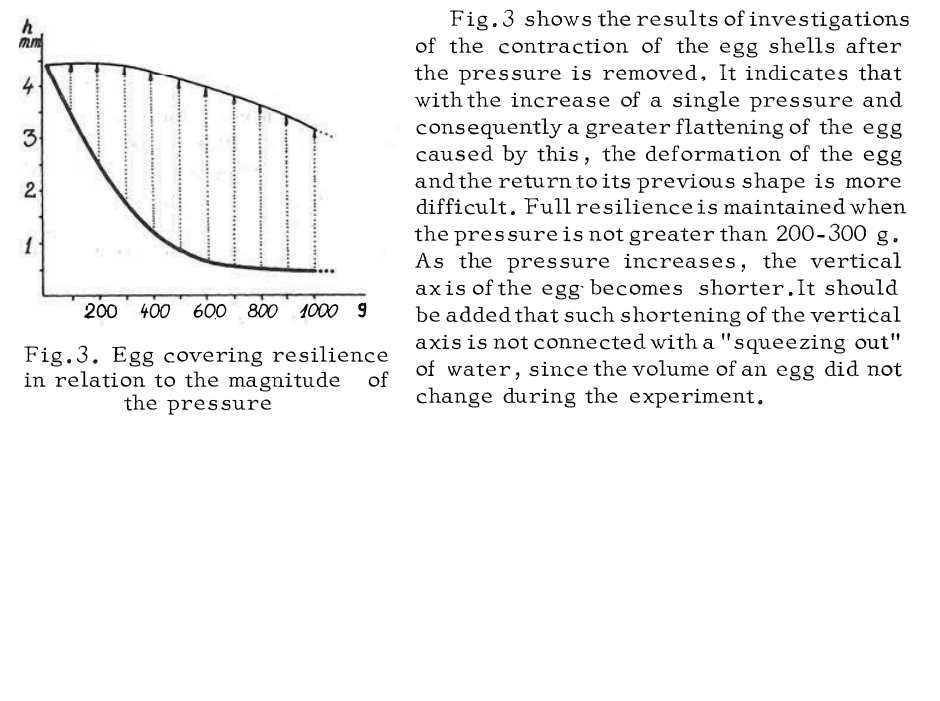
Fig.2. Stretching of the egg shells under mechanical